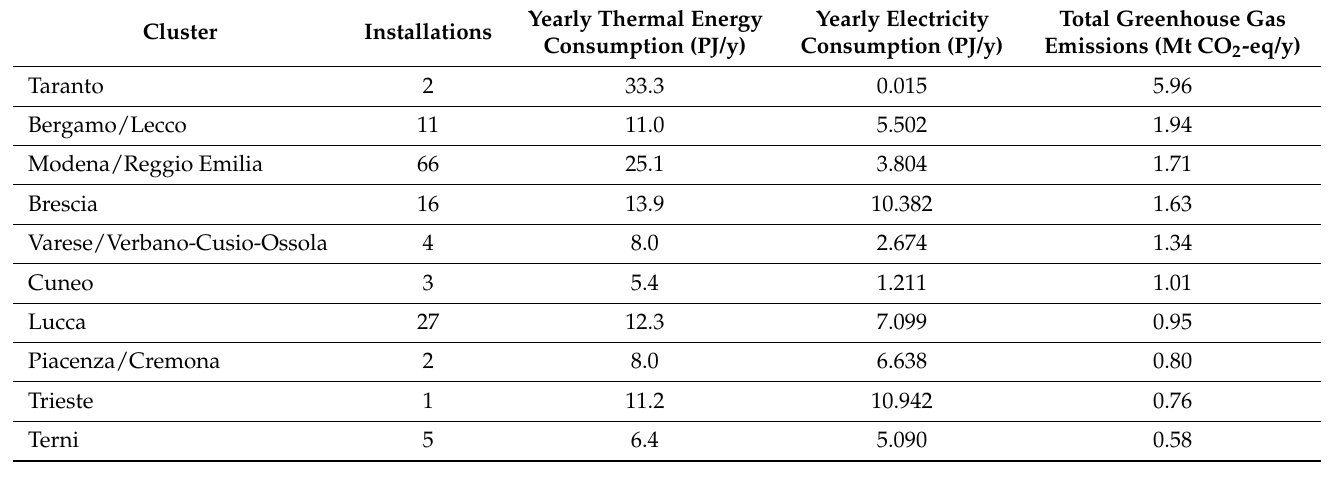
Table 11. Ranking of clusters per carbon dioxide emissions and thermal energy consumption.